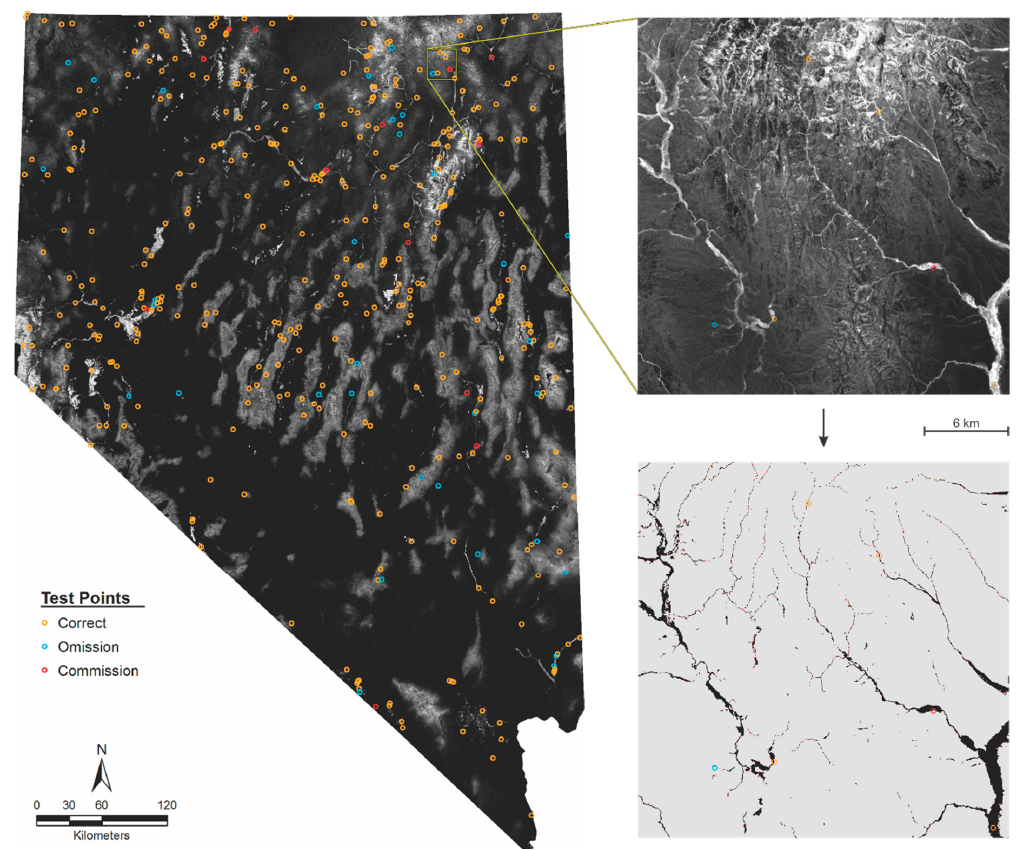
Figure 3. Accuracy assessment points overlain on NDVI and mapped riparian area (lower right).